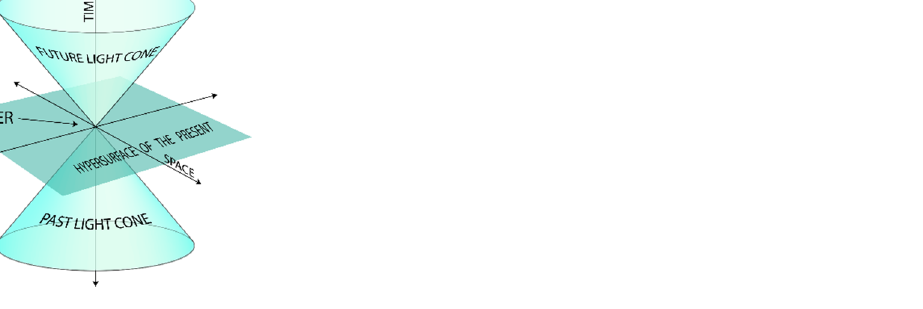
Figure 1. Intuitive representation of Minkowski’s light-cone of special relativity, which is defined on complex numbers, where the future-directed states are defined on real numbers and the past-directed states are defined on imaginary numbers.